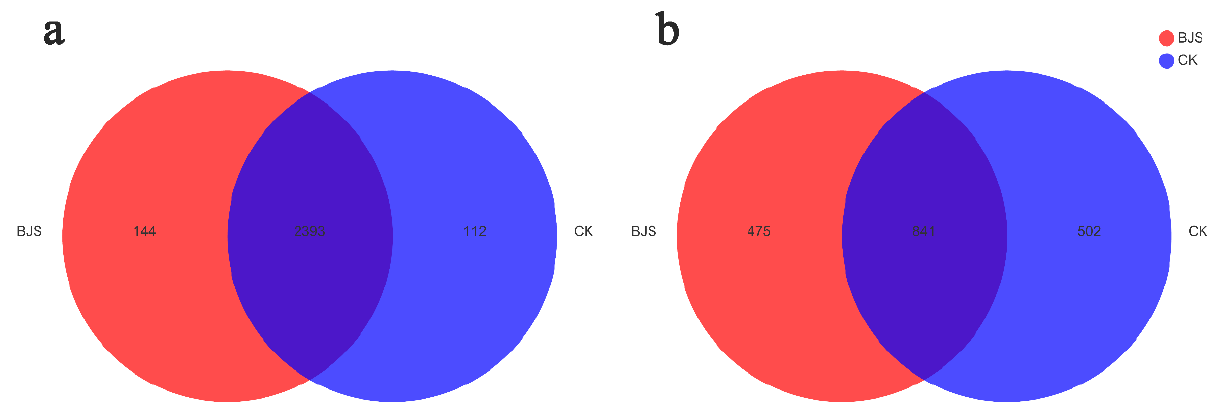
Figure 5. A Venn diagram illustrating the differences and similarities between the two treatments in terms of bacterial ( a ) and fungal ( b ) OTUs. “BJS” means BJS-1-3 fermentation-broth-treated poplar group; “CK” means sterilized fermentation-broth-treated poplar group. For each treatment, three replicates were analyzed.